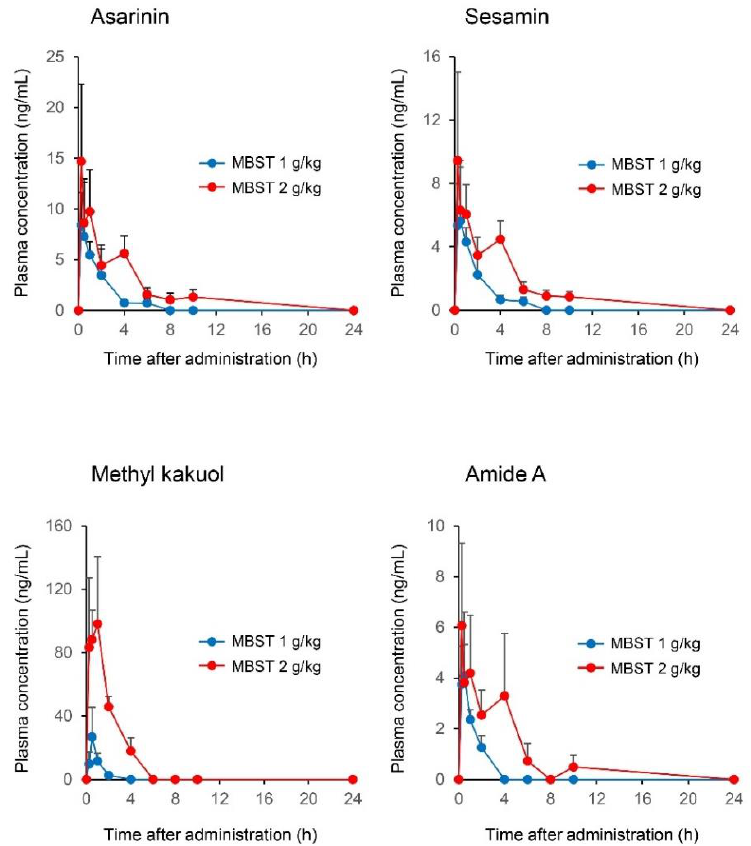
Figure 2. The plasma concentration-time profiles of asarinin, sesamin, methyl kakuol, and amide A ((2 E ,4 E ,8 Z ,10 E )- N -isobutyl-2,4,8,10-dodecatetraenamide) derived from Asiasari Radix. Each plasma sample was obtained from whole rat blood after oral dosing of maobushisaishinto (MBST) at 1 or 2 g / kg dose and was analyzed via LC-MS / MS system using selected reaction monitoring mode. The MBST of 1 g / kg contains 578 µ g / kg, 147 µ g / kg, 226 µ g / kg, 426 µ g / kg asarinin, sesamin, methyl kakuol, and amide A, respectively. Individual points represent the mean + standard deviation for three independent animals. The pharmacokinetic analyses of the compounds were performed by a non-compartmental analysis (calculated pharmacokinetic parameters are shown in Table